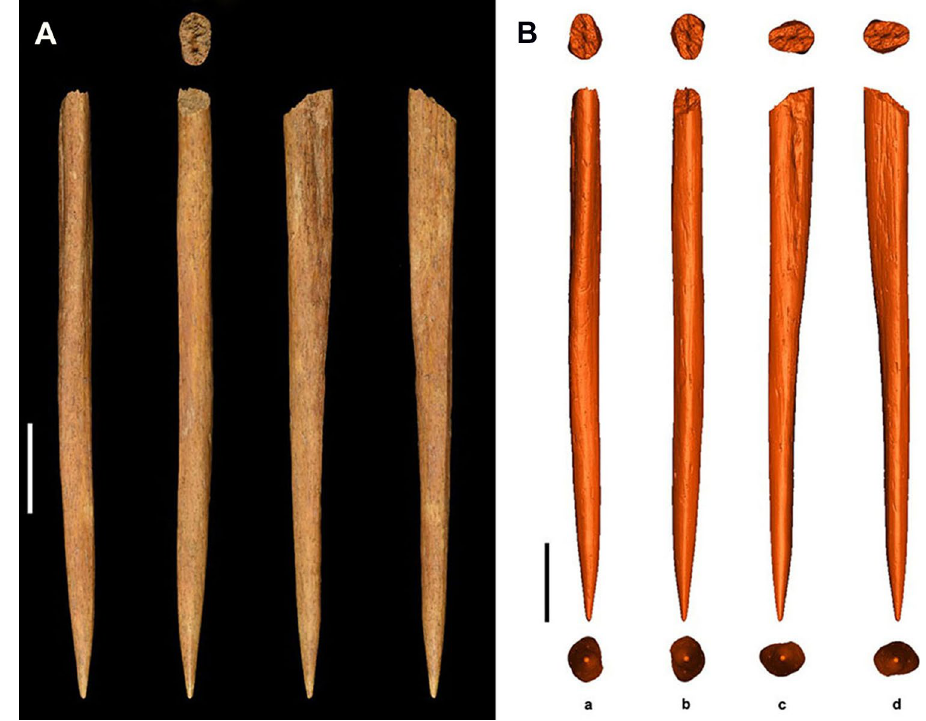
Figure 3. Stajnia awl. ( A ) Original picture of the awl from Stajnia Cave; ( B ) Reconstructed 3D digital models of the awl. Scale bars are 1